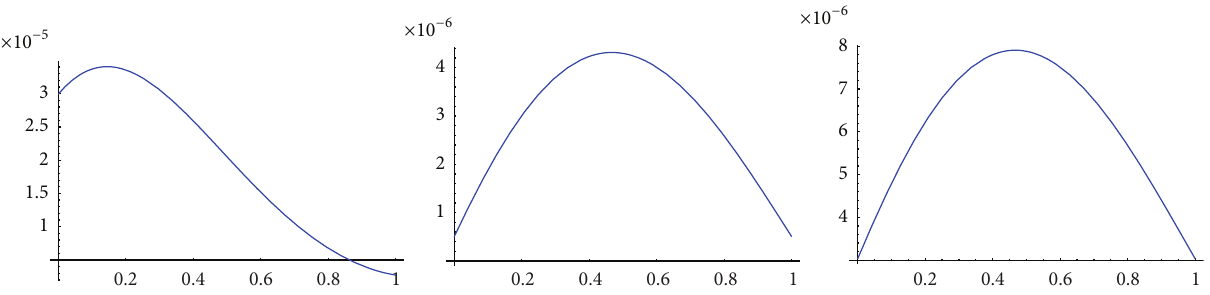
Figure 1: R.M.S of the exact solution 𝑦 𝑘 (𝑥) and the approximate solution 𝑦 𝑘 𝑛 (𝑥) ( 𝑘 = 0, 1,2 ).